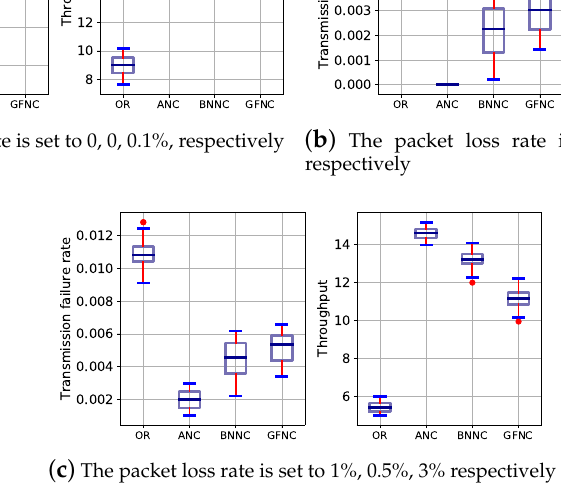
Figure 8. The transmission failure rate and throughput performance of different schemes in